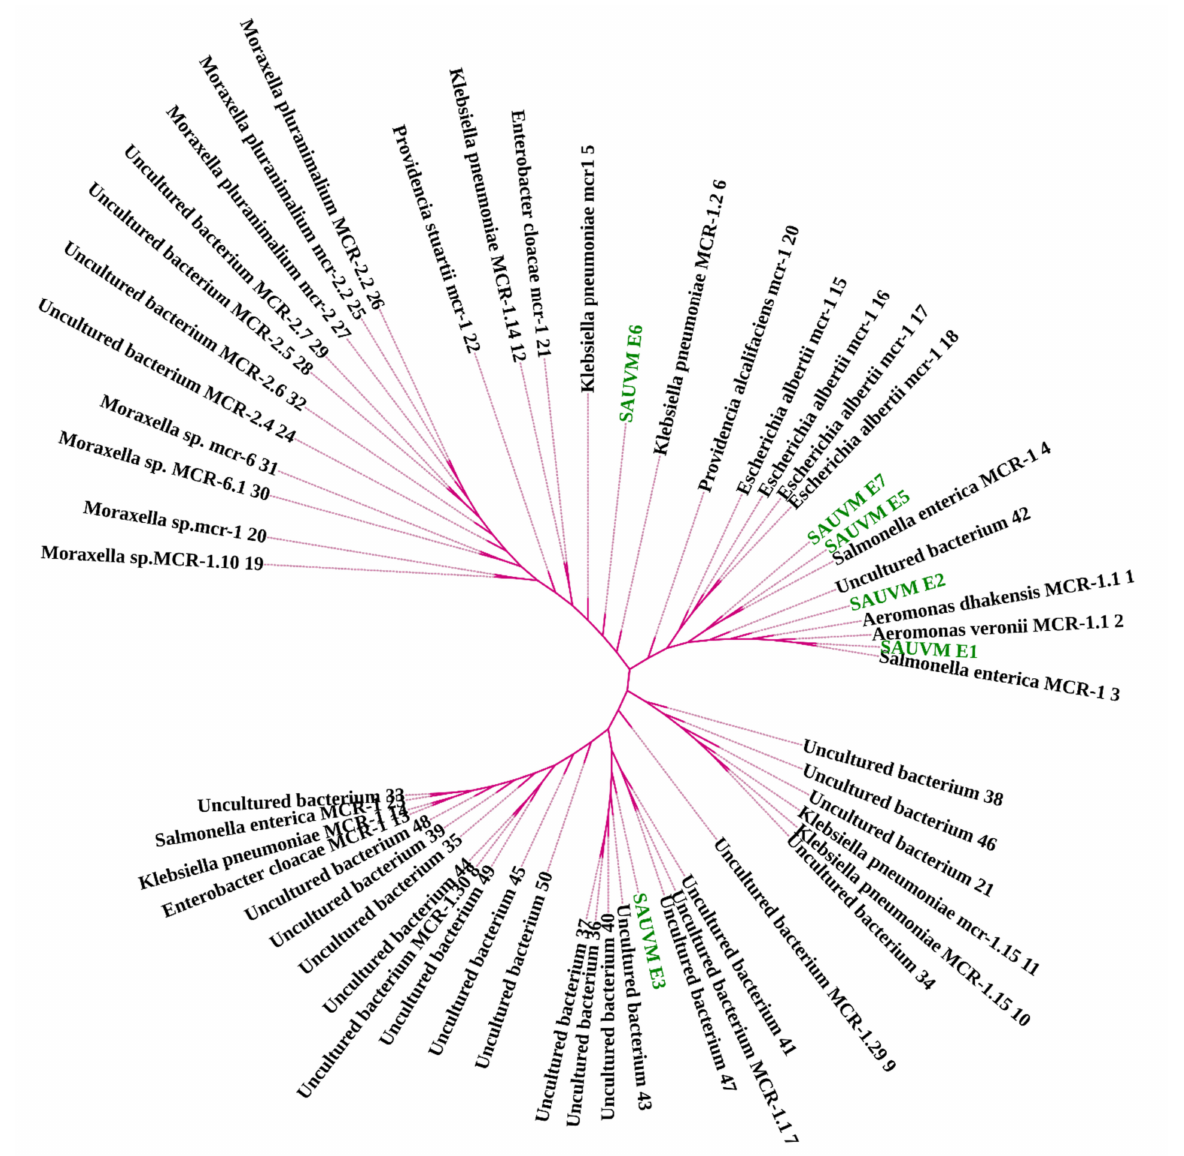
Figure 3. Phylogeny of 52 MCR-1 proteins retrieved from NCBI database, except E. coli, including sequenced SAUVM MCR-1. Phylogenetic study of MCR-1 and MCR-1-like proteins reveals ancestral origins and diversification. Using amino acid sequences from six SAUVM MCR-1 proteins, the BLAST search tool (https://blast.ncbi.nlm.nih.gov/Blast.cgi accessed on 16 March 2021) was used to retrieve homologous sequences of MCR-1 and MCR-1-like proteins from the NCBI database. MCR-1 and MCR-1-like proteins of E. coli , Salmonella , and strains containing LptA (formerly known as EptA) and others were among the sequences categorized. Using aligned MCR-1 sequences from CLUSTALW, the maximum likelihood method of MEGA X was used to create a phylogenetic